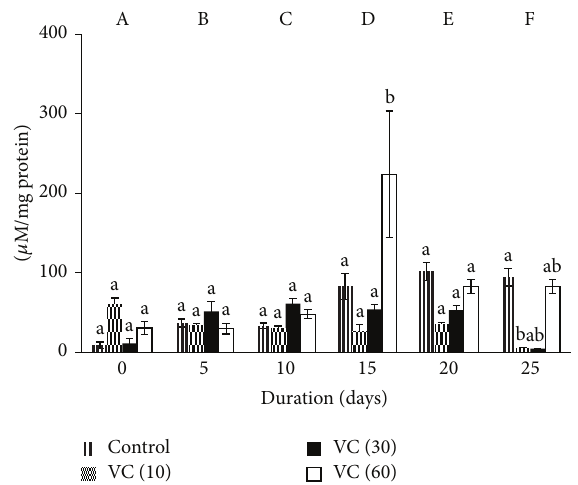
Figure 6: Protein sulfhydryls in plasma isolated from stored blood. Values are mean ± SE of five animals/group. VC (10): vitamin C (10mM); VC (30): vitamin C (30mM), and VC (60): vitamin C (60mM).Two-wayANOVAwasperformedbetweenthegroupsand subgroups. A–F values between the groups are significantly different at 𝑃 < 0 . 05.Changeswithinthegroupsarerepresentedinlowercase. Those not sharing the same letters are significantly